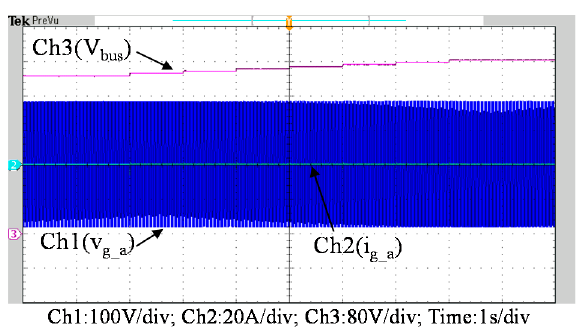
Figure 30. Waveforms of DC bus voltage (V bus ), phase-a grid voltage (V g_a ) and a-phase grid current (i g_a ).